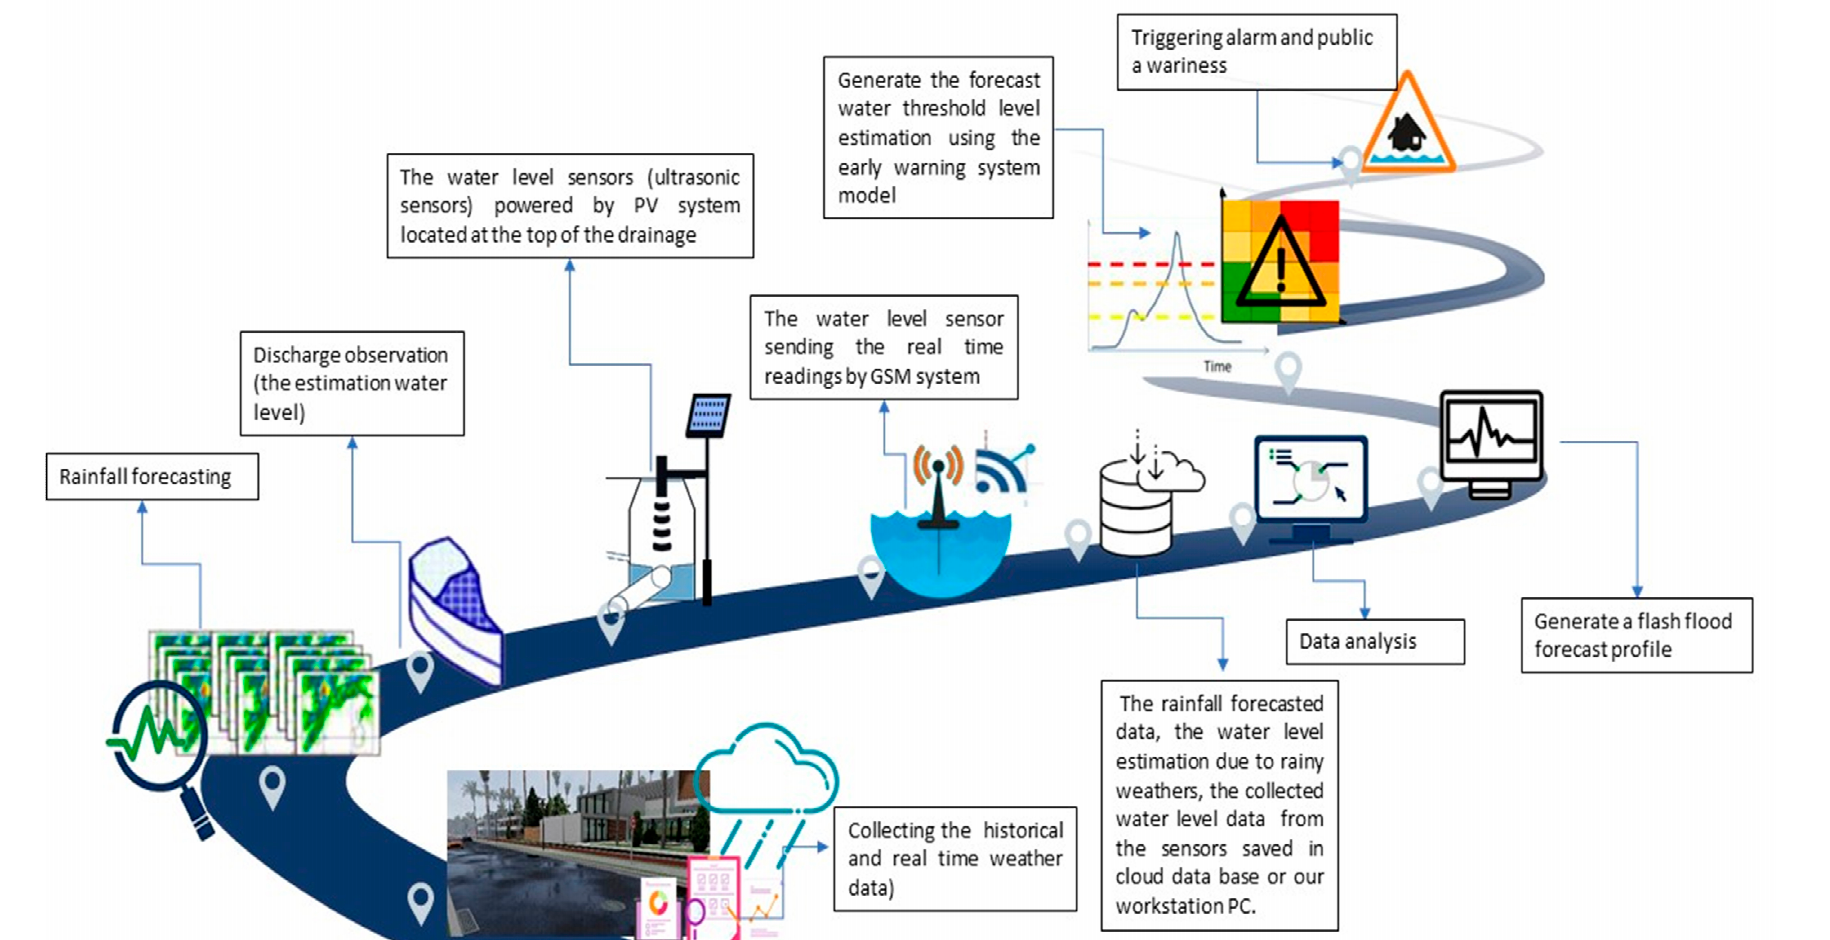
Figure 3. The main mechanism of the